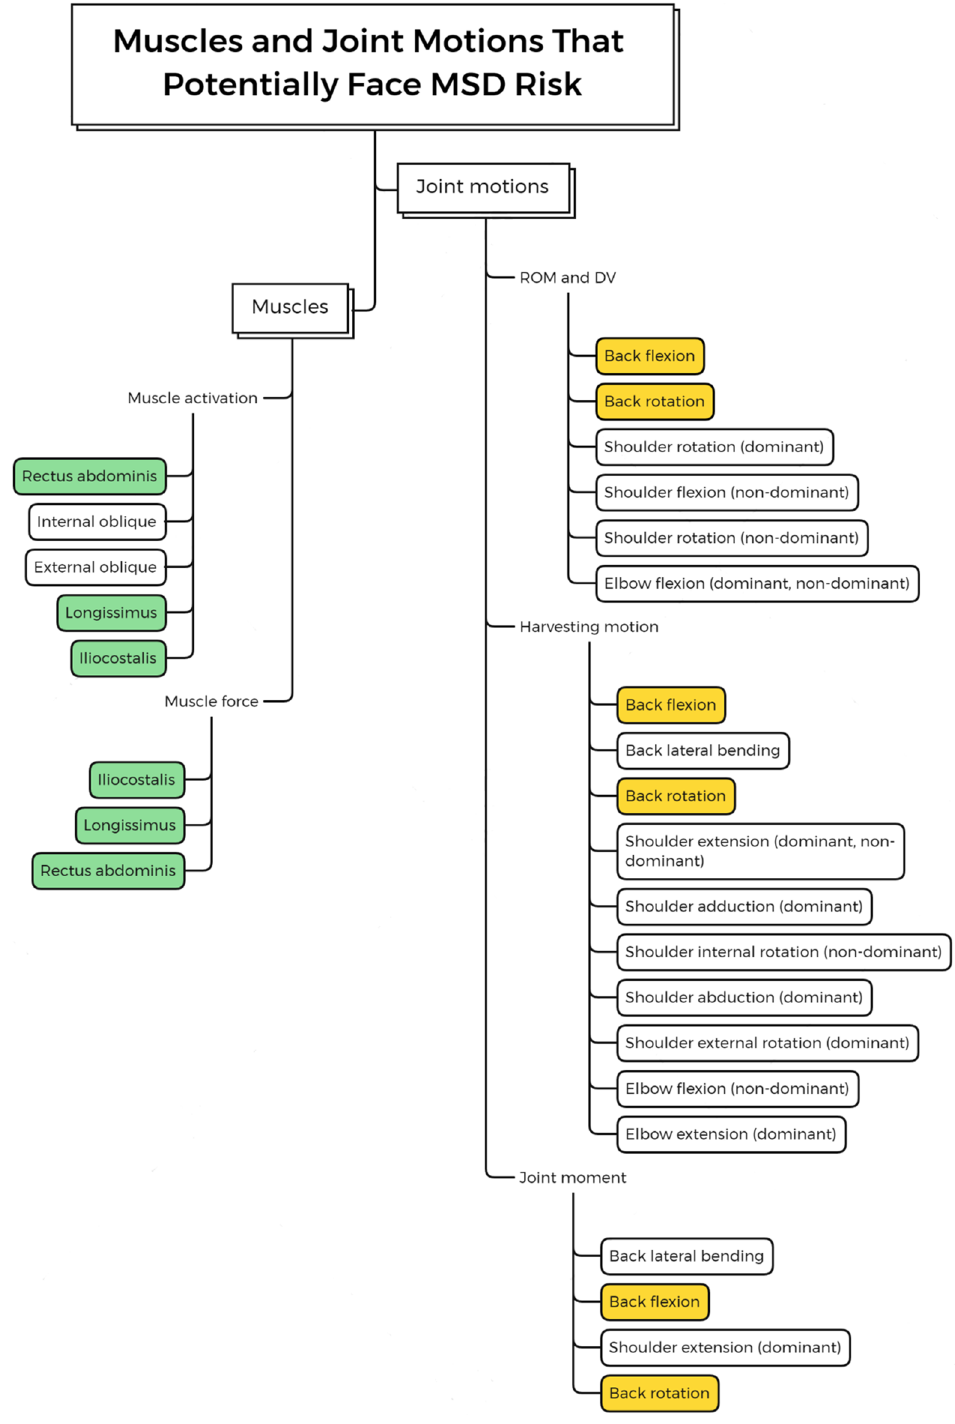
Figure 6. Muscles and joint motions that potentially face MSD